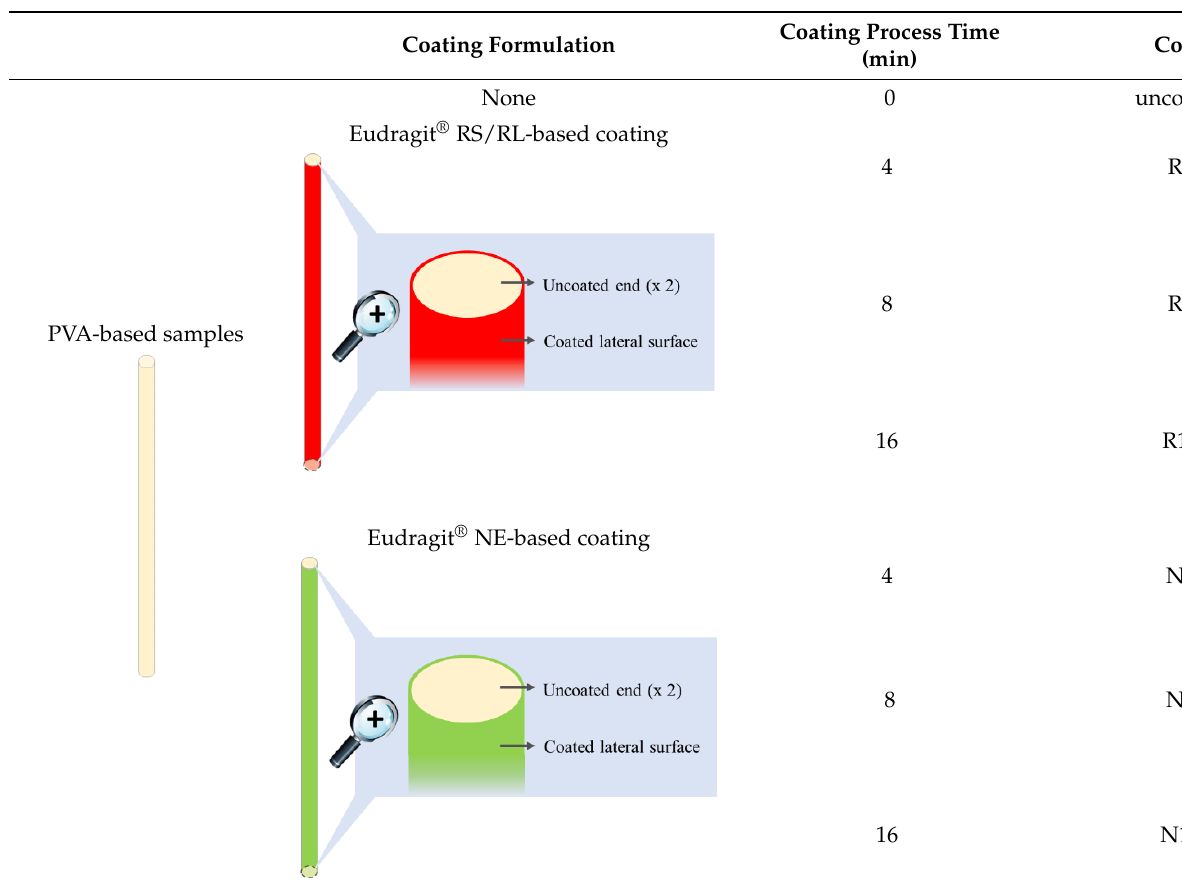
Table 2. Uncoated and coated samples with the relevant manufacturing details and identification codes.